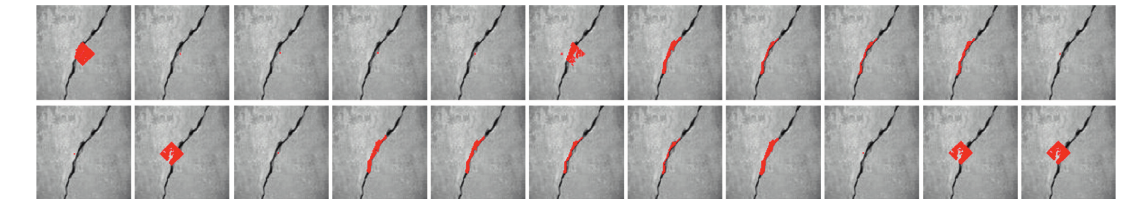
Figure 15: Percolated results using conditional termination and skip strategies.